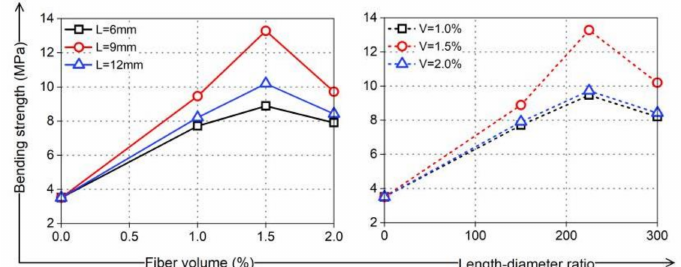
Figure 11. Bending strength of PVA-reinforced coral cement-based composites.